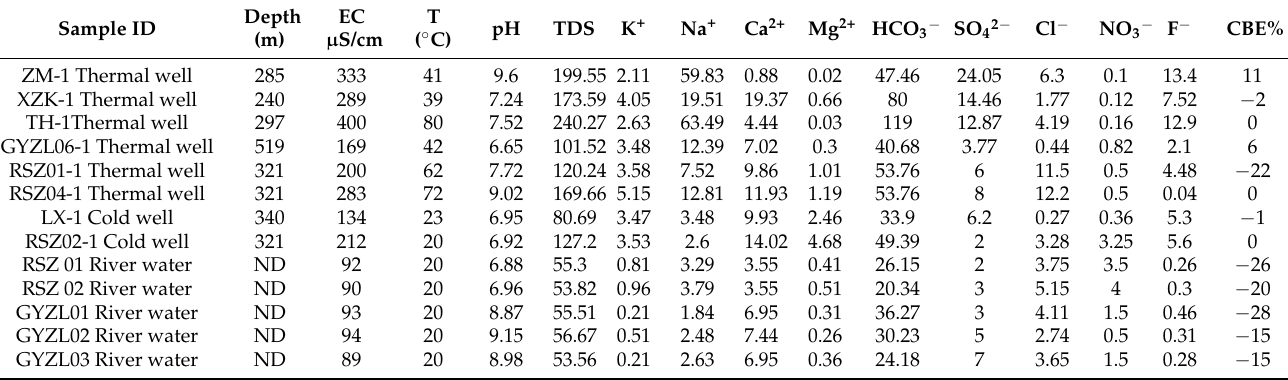
Table 1. Hydrochemical parameters of sampled waters from Suichuan County, SE China. TDS and other chemical concentrations are in